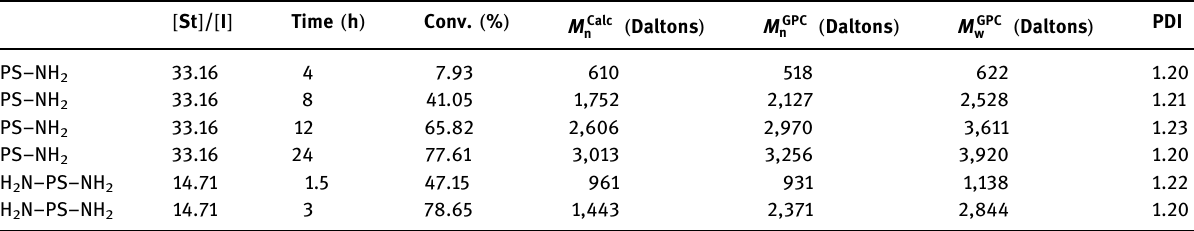
Table 1: Molecular weight and polydispersity of aminated